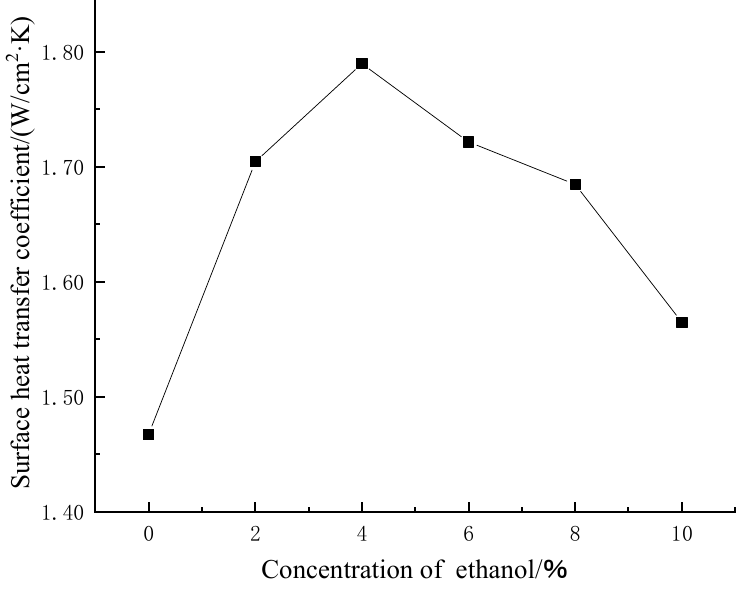
Figure 20. Schematic diagram of the structure of CTAB molecular adsorption bubbles. Figure 21 shows the spray cooling steady-state heat transfer coefficients at different ethanol concentrations, and Figure 22 shows the visualization of the spray chamber interior at different concentrations. As with CTAB, the surface heat transfer coefficient first increases and then decreases with increasing ethanol concentration. The maximum heat transfer coefficient of 1.79 W/cm 2 · K is reached at 4% ethanol volume fraction, which is 21.8% higher than that of pure water.